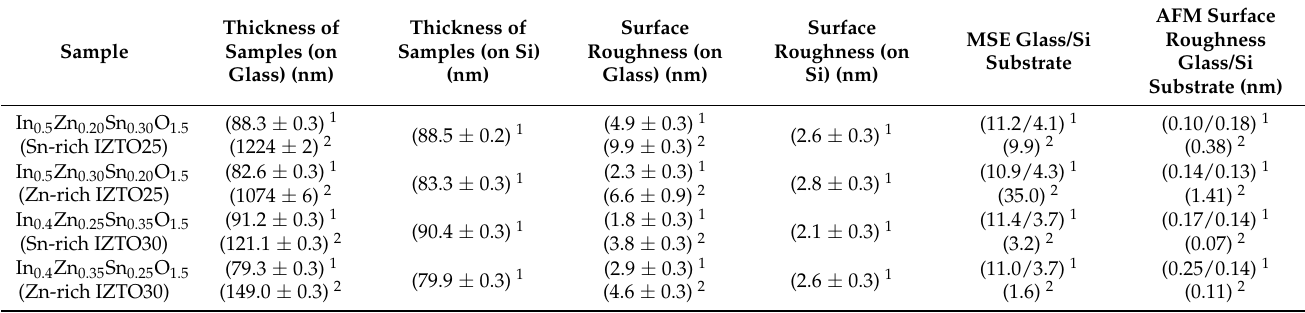
Annealed layers of different thicknesses (of about 150 nm for IZTO30 films and of about 1 µ m for IZTO25 films) were also analyzed. Table 1. Thickness, surface roughness, and mean square error (MSE) of non-stoichiometric IZTO films deposited onto glass and SiO 2 /Si substrates and annealed non-stoichiometric IZTO films onto glass substrates obtained by the best fit of ellipsometry data together with surface roughness obtained from atomic force microscopy (AFM). AFM Surface Thickness of Thickness of Surface Surface MSE Glass/Si Roughness Sample Samples (on Samples (on Si) Roughness (on Roughness (on Substrate Glass/Si Glass) (nm) (nm) Glass) (nm) Substrate (nm)